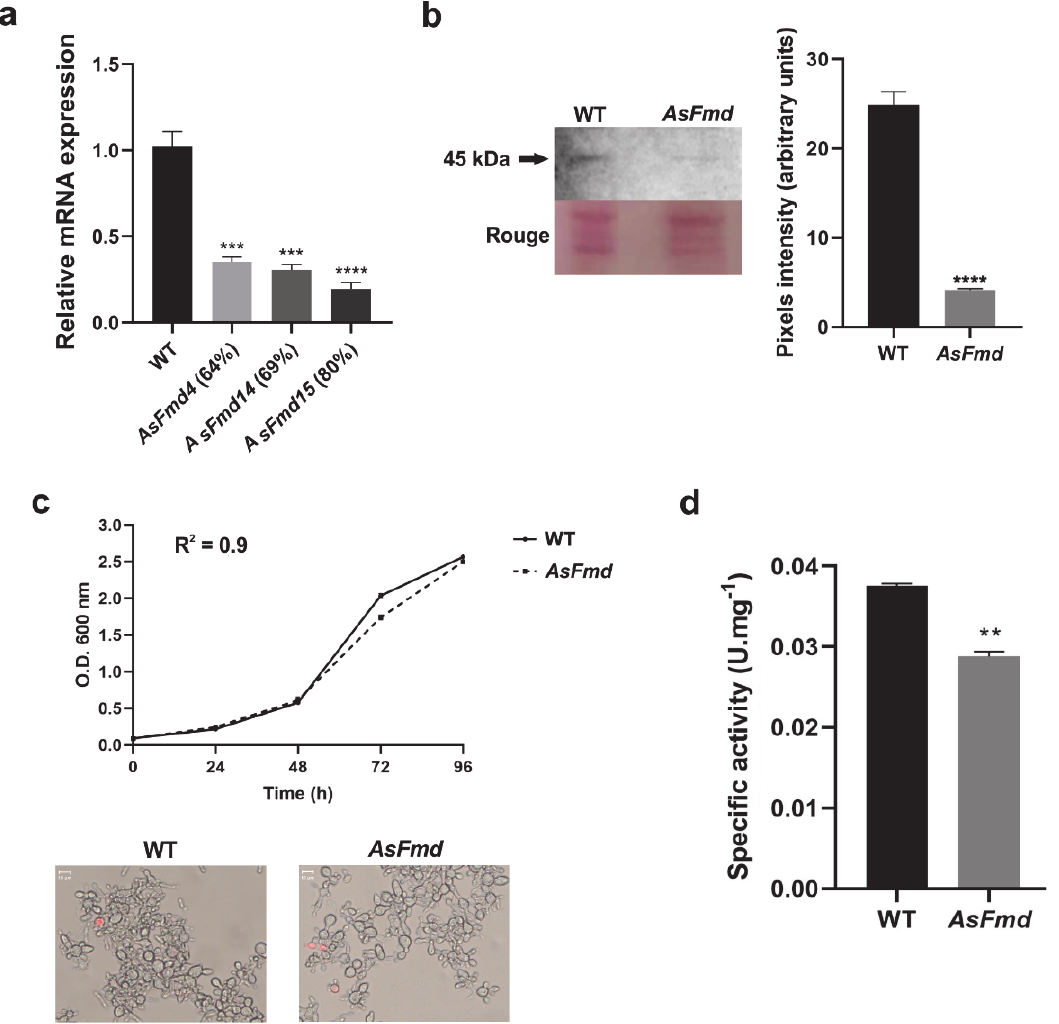
Figure 2. P. lutzii fmd gene silencing. ( a ): Relative quantification of fmd expression in WT and AsFmd strains through RT ‐ qPCR. The tubulin gene (PAAG_03031) was used as endogenous control. ( b ): Fmd expression analysis in WT and AsFmd strains through immunoblotting. Rouge: WT and AsFmd protein extract stained with Rouge ‐ Ponceau exhibiting similar protein quantification. Polyclonal antibody anti ‐ Pb Fmd was incubated with 30 μ g of protein extracts. Pixel intensity was measured by densitometric analysis of immunoblotting bands using ImageJ software. Pixel intensity from three replicates was measured by densitometric analysis of immunoblotting bands using ImageJ software. ( c ): Growth and viability of WT and AsFmd strains. WT and AsFmd strains were grown in BHI for 96 h. O.D. was measured daily at 600 nm to determine growth curve. Microscopy represents P. lutzii cell viability that was accessed by staining with propidium iodide (1 μ g/mL) on the last day of the growth curve. Dead cells are colored in red. Images were obtained using an Axioscope A1 microscope (Carl Zeiss) at 493/623 nm and magnified 1000×. ( d ): Formamidase enzymatic activity in 500 ng of WT and AsFmd protein extract. Error bars represent standard deviation of three experimental replicates. Shapiro–Wilk test was employed to determine data normality: RT ‐ qPCR ( p values > 0.2), densitometric analysis of immunoblotting bands ( p values > 0.2) and formamidase activity ( p values > 0.8). Student’s t ‐ test was applied for statistical analysis of relative quantification of fmd expression through RT ‐ qPCR and densitometric analysis of immunoblotting bands. **** represents p values < 0.000, *** represents p values ≤ 0.0005 and ** represents p values ≤ 0.005.